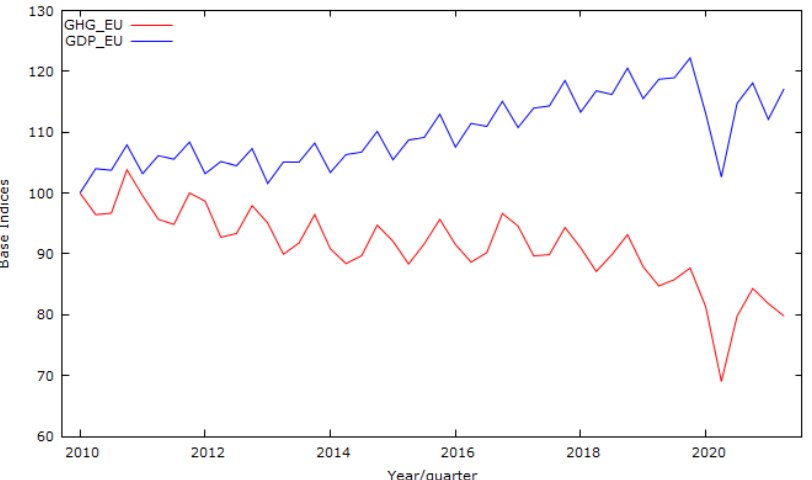
Figure 3. GDP over GHG in the EU-27 countries. Note: ln—natural logarithm, EU-27—27 European Union countries, GDP—GDP at constant prices, GHG—air emissions accounting for greenhouse gases. Source: Compiled by the authors, based on Eurostat (2022).